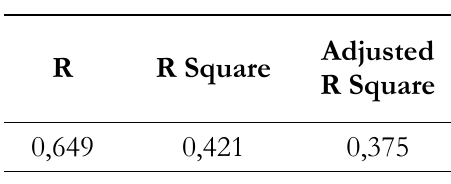
Table 7. R Determination